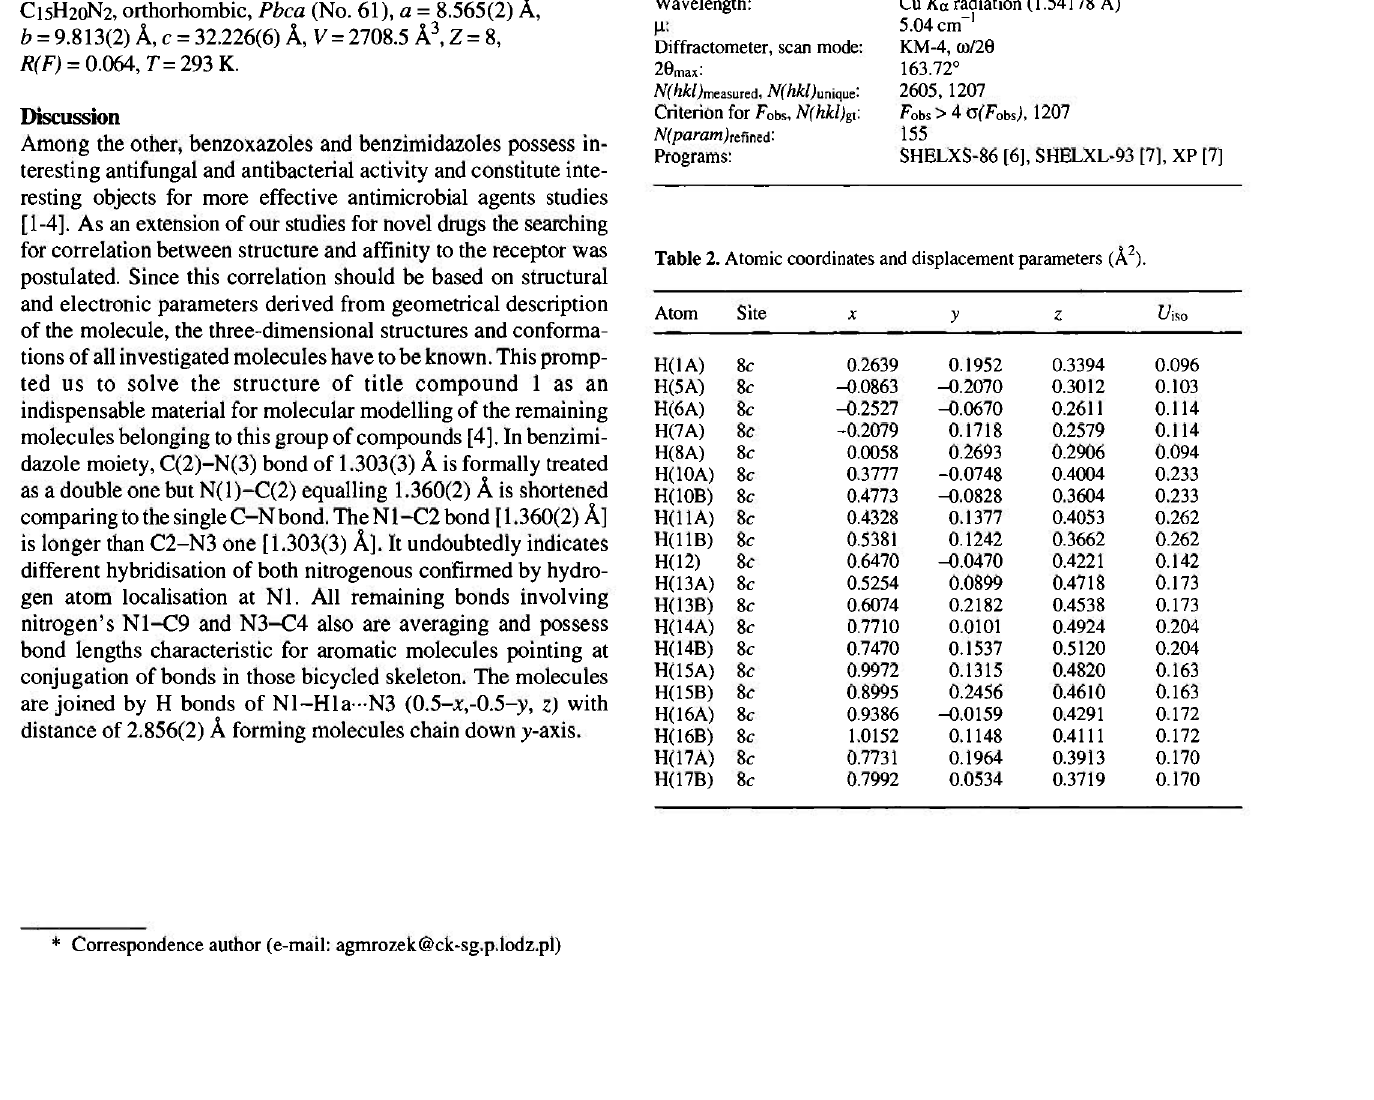
Table X. Data collection and handling. Crystal: